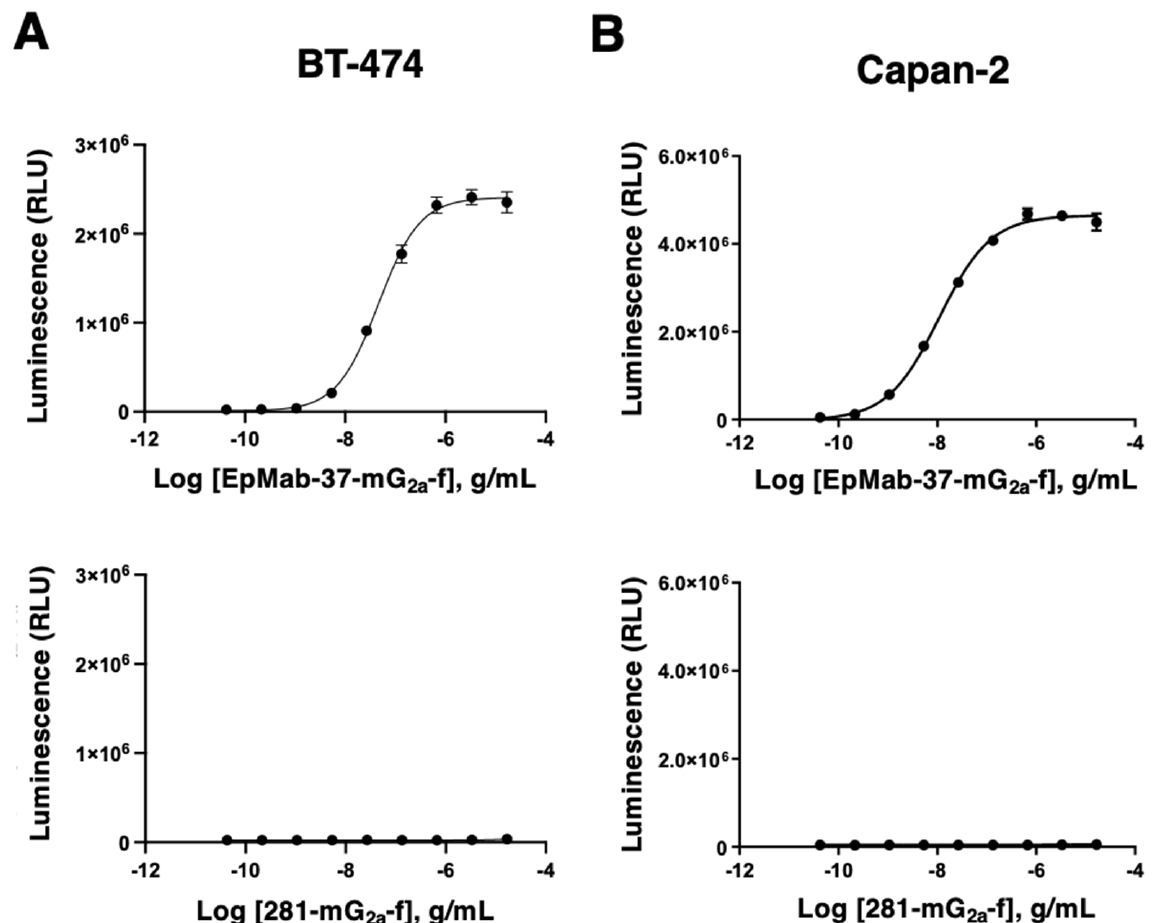
Figure 3. ADCC reporter assay by EpMab-37-mG 2a -f and 281-mG 2a -f in the presence of BT-474 and Capan-2 cells. ( A , B ) Target cells (BT-474 ( A ) and Capan-2 ( B )) were treated with serially diluted EpMab-37-mG 2a -f and 281-mG 2a -f (mouse IgG 2a control). Then, Jurkat cells stably expressing the hu- man FcγRIIIa receptor and an NFAT response element driving firefly luciferase were added and co- cultured. Luminescence was measured using the Bio-Glo Luciferase Assay System. ADCC, anti- body-dependent cellular cytotoxicity.